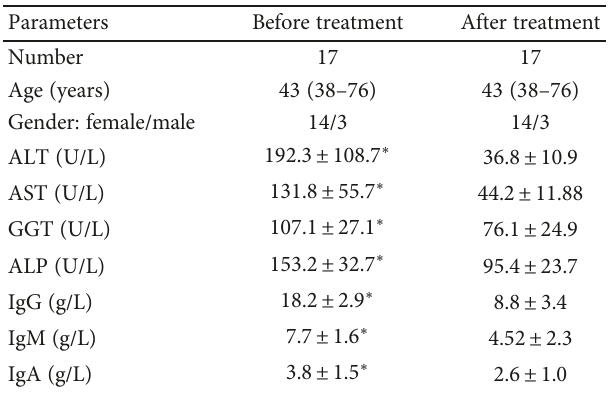
Table 2: E ff ect of treatment on the values of clinical measures in AIH patients.